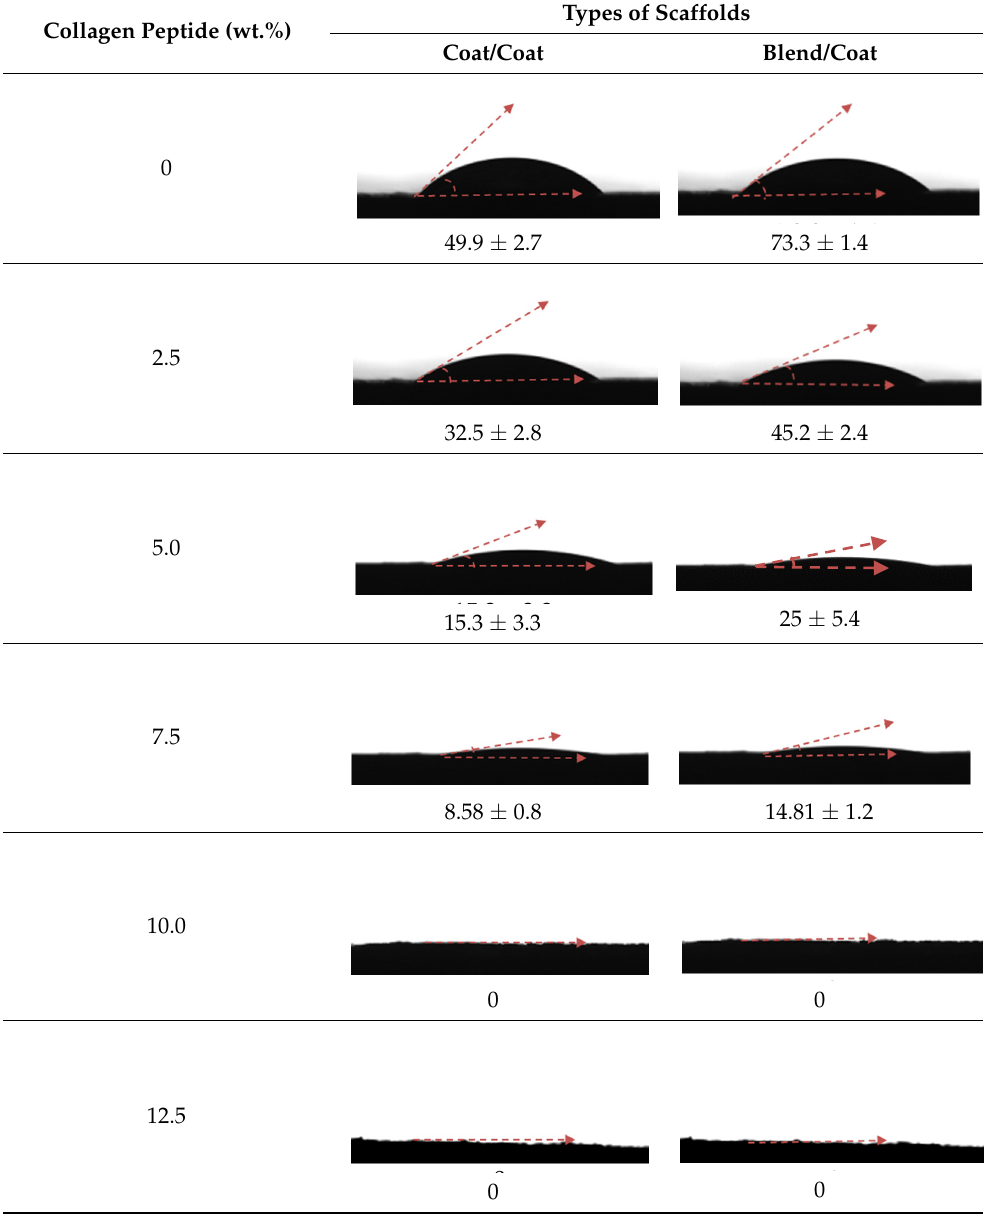
Table 3. Water contact angle of scaffolds with various collagen peptide concentration. Collagen Peptide (wt.%)